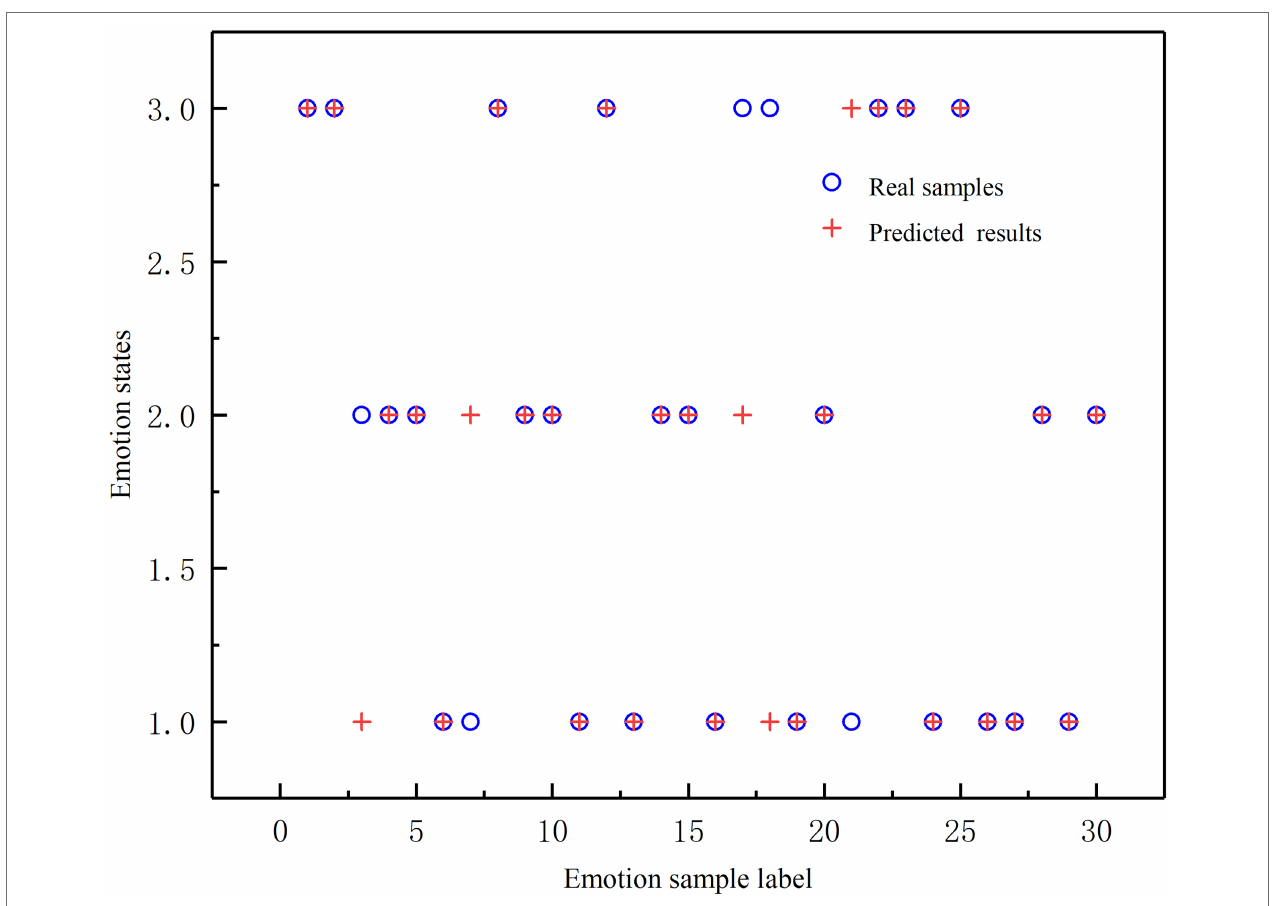
FIGURE 5 | SVM classification prediction